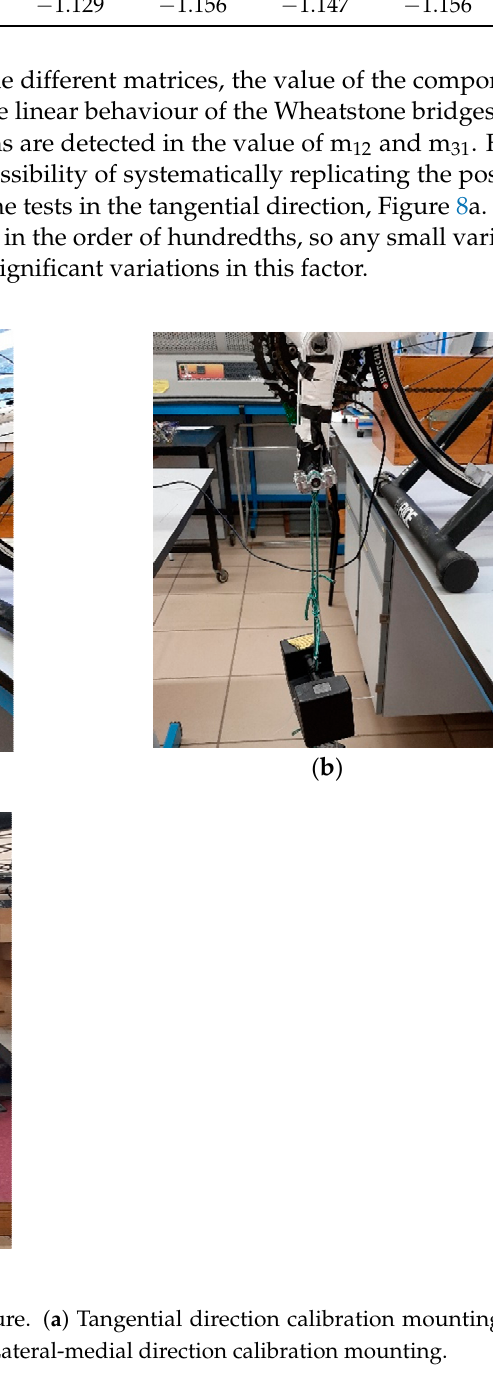
Table 2. Components of the M matrix for different calibration loads.